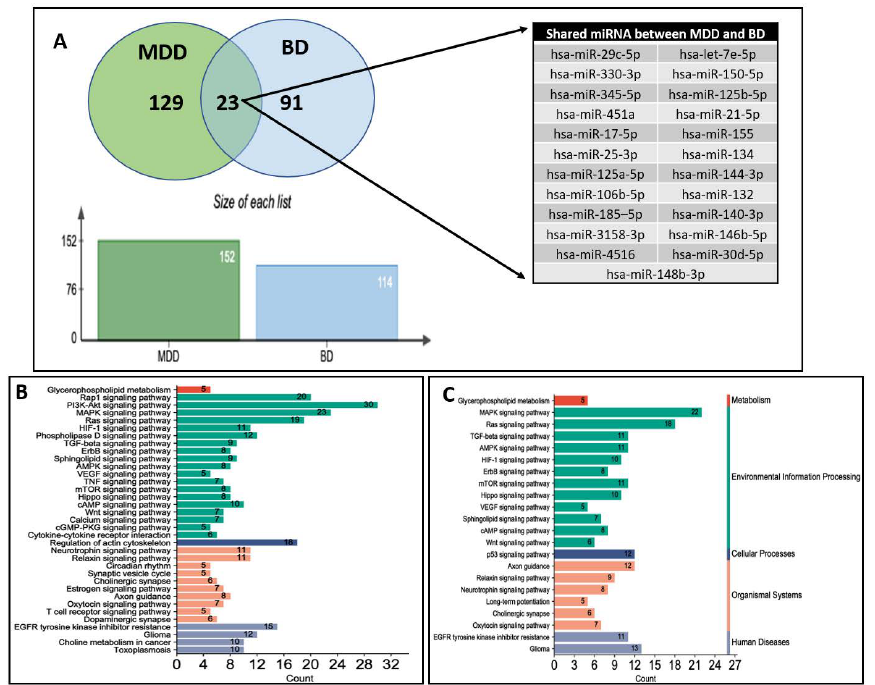
Figure 1. ( A ) Venn diagram showing the comparison of exclusive and shared miRNAs between MDD and BD groups. Bar plot showing total number of miRNAs in MDD (152) and BP (114) groups and a list of 23 shared miRNAs between MDD and BD are also depicted; ( B ) Bar plot showing pathway clustering based on the number of genes targeted by 129 miRNAs associated with MDD; ( C ) Bar plot showing pathway clustering based on the number of genes targeted by 91 miRNAs associated with